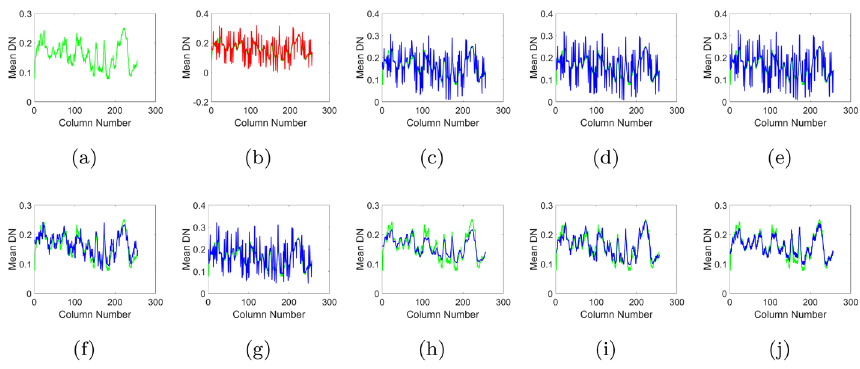
Fig. 4 Vertical mean profiles of band 2 in the Washington DC Mall image a Original image; b Noisy image; before and after denoising via the different methods: c BM4D; d LRMR; e NAILRMA; f LLRGTV; g MTGSNMF; h SSTVSSLR; i HSI-SDeCNN; j SRGLR (proposed). The green, red, and blue curves represent the mean DN of the clean, noisy and restored images, respectively